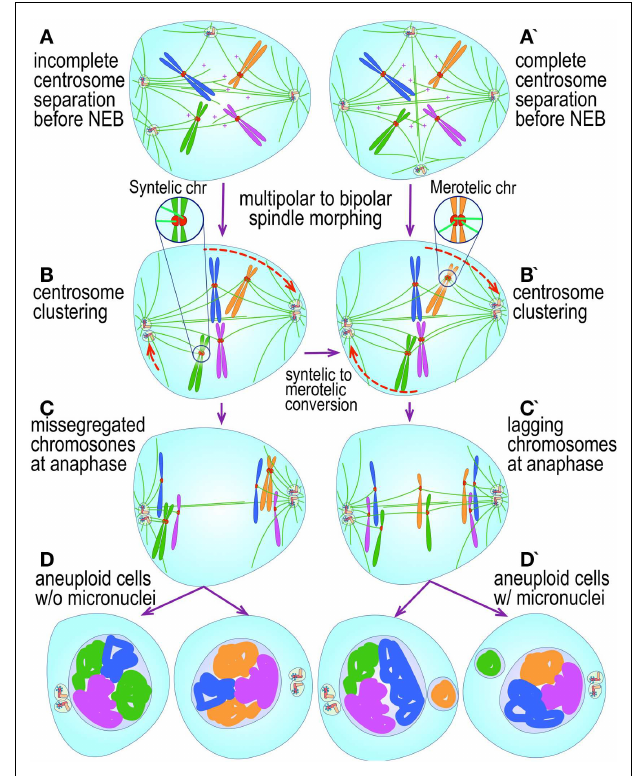
FIGURE 6 | Multipolar to bipolar spindle reconfiguration in cancer cells . Cancer cells with supernumerary centrosomes enact multipolar spindles (A,A’) , but after some delay, reconfigure their spindles to bipolar structures with centrosomes clustered at the poles (B,B’) . Abnormal chromosome attachments acquired during the multipolar stage, such has synthelic (B) or merothelic (B’) , may then lead to monopolar segregation (C) or lagging (C’) chromosomes, which are usually incorporated into micronuclei, resulting in aneuploid cells with supernumerary centrosomes without (D) or with micronuclei (D’)